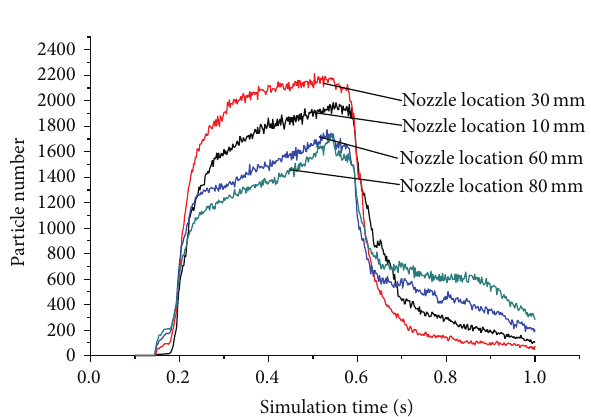
Figure 6: The number of extrusive particles in 0.4 s feeding time.